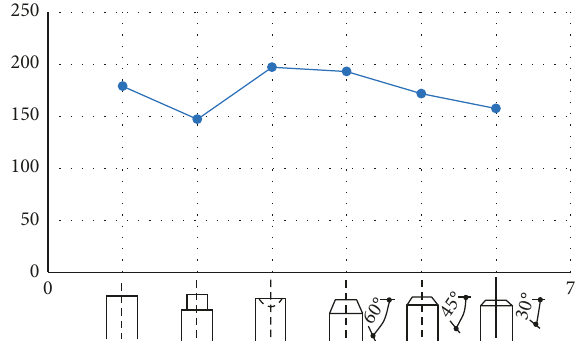
Figure 7: Tensile strength limit obtained with aluminum pins with altered geometries.